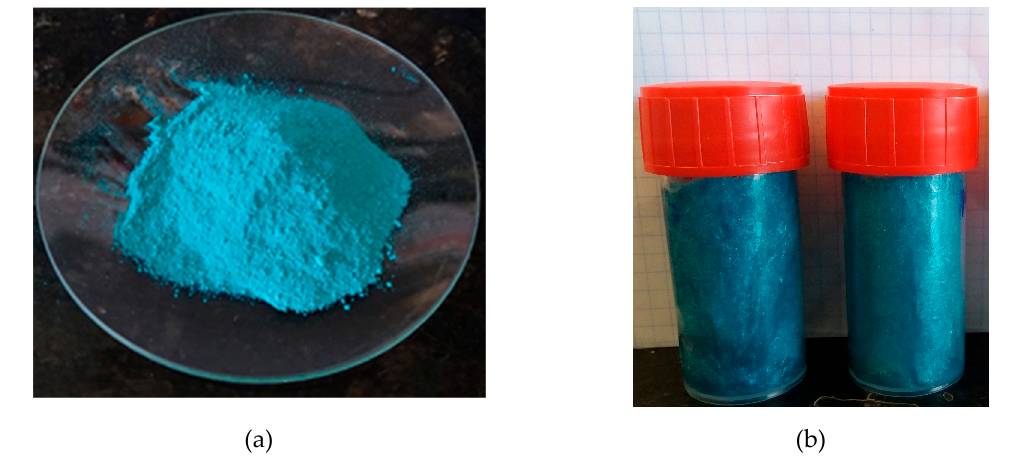
Figure 8. ( a ) Synthetized copper (II) oxide (CuO) nanoparticles; ( b ) nano-enhanced phase change